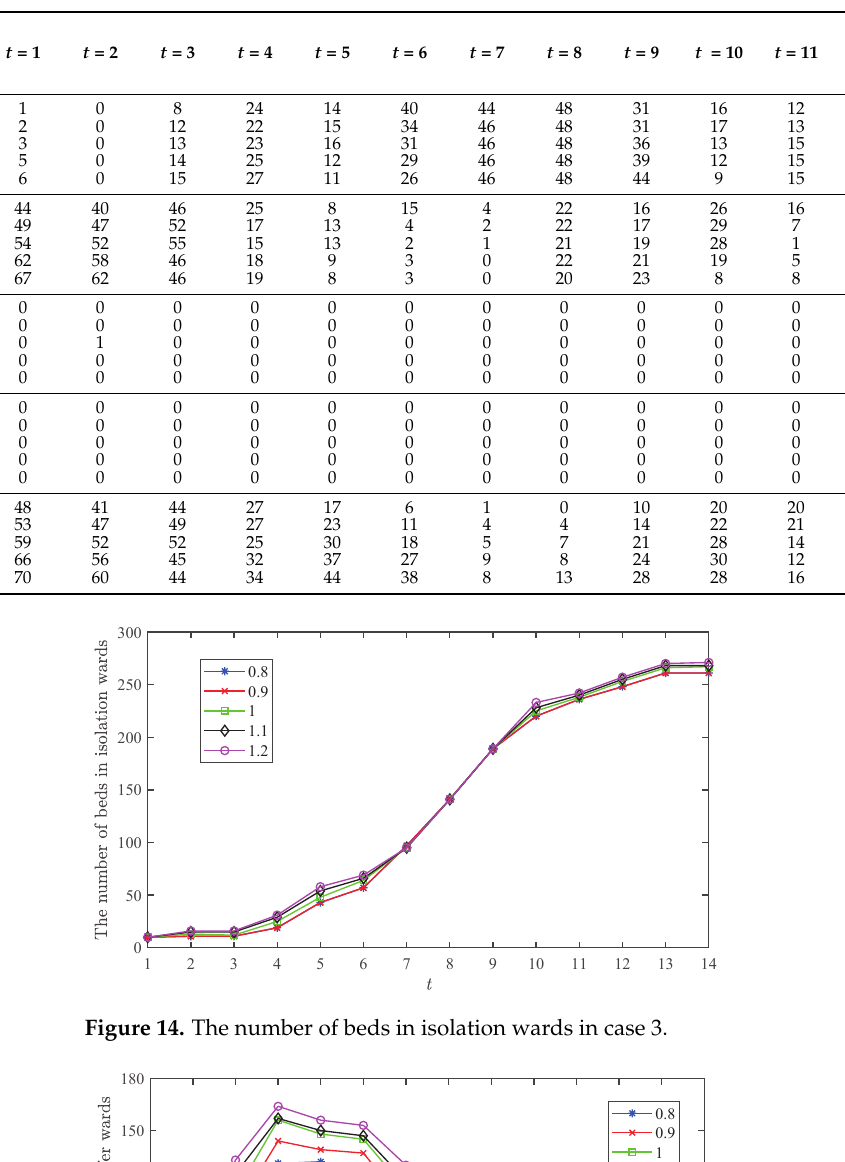
Table 9. Comparison of optimal decision schemes in case 3.